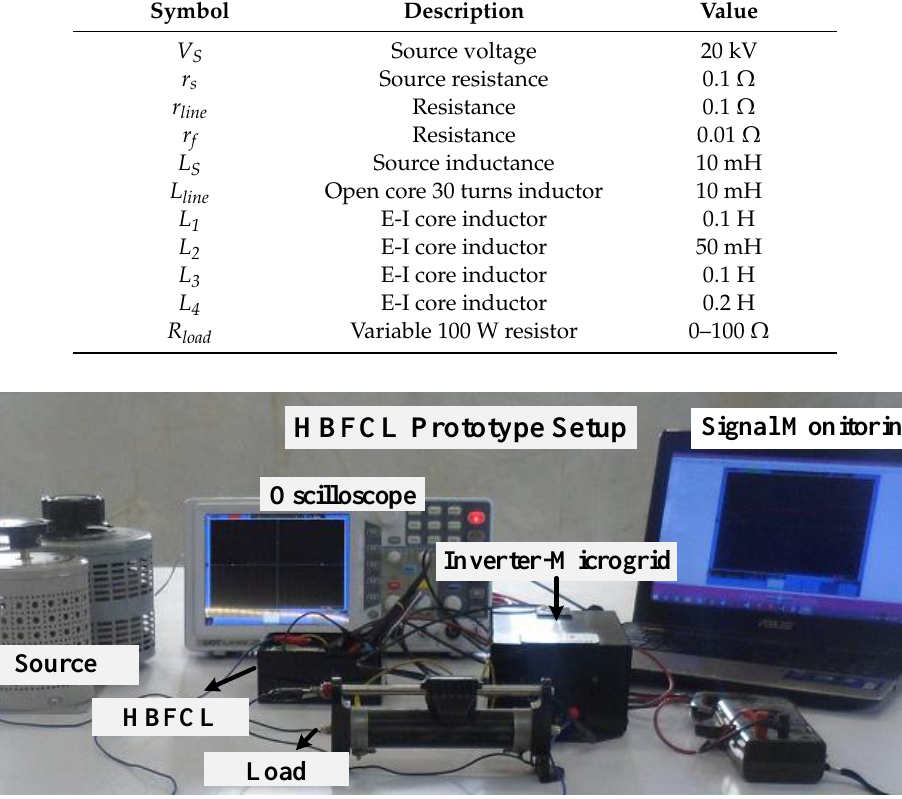
Figure 9. The proposed experimental setup.